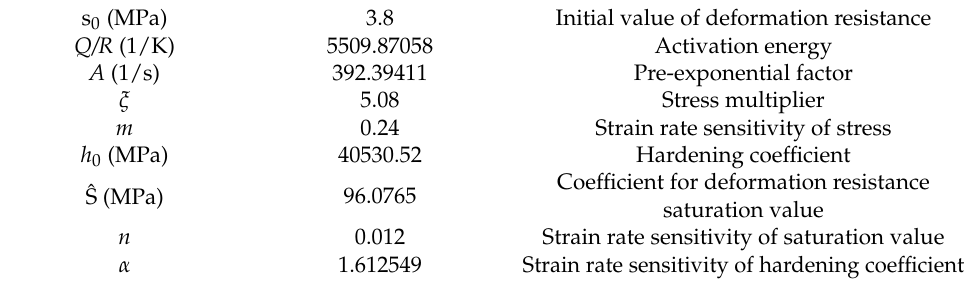
Table 5. The parameters of the Anand model for the solder joint.